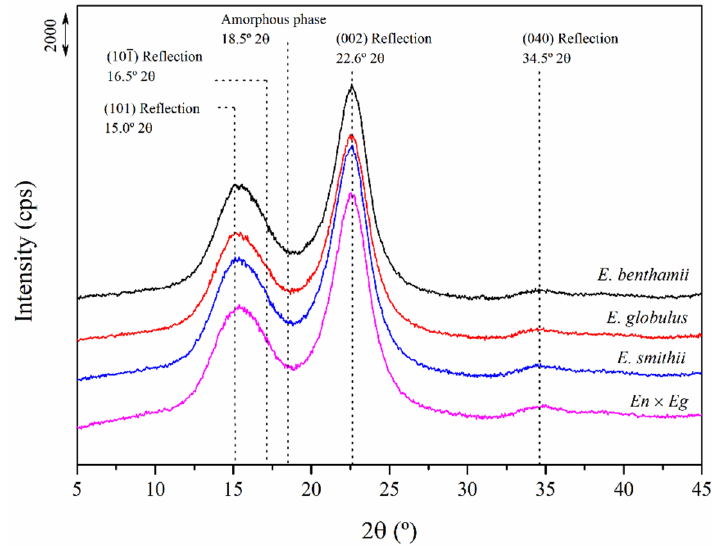
Figure 3. X-ray diffraction (XRD) spectra of the CNCs obtained from the different eucalyptus species. Table 3. Obtaining yield along with apparent crystallinity degree ( CrI ), lateral crystallite size ( L 002 ), infrared crystallinity index ( ICI ), and infrared crystallinity ratio ( ICR ) of CNC obtained from the different eucalyptus